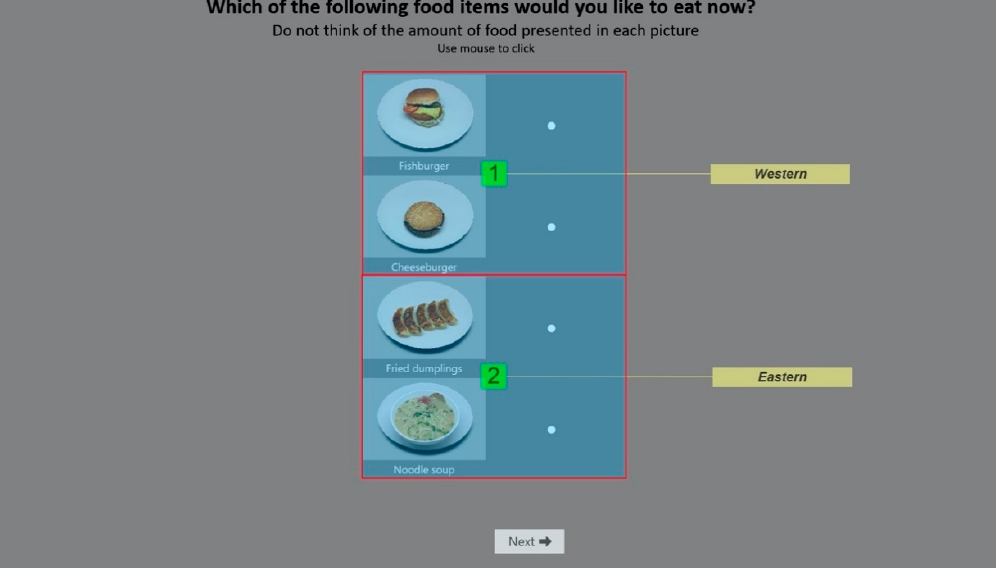
Figure 1. Example of a choice stimulus with two Western food items on the top and two Eastern food items on the bottom. Participants were instructed to choose one of the four food items that they wanted to eat the most using a mouse click. The overlaid labels indicated corresponds to the AOIs drawn out in the iMotions software ® (not shown to participants).